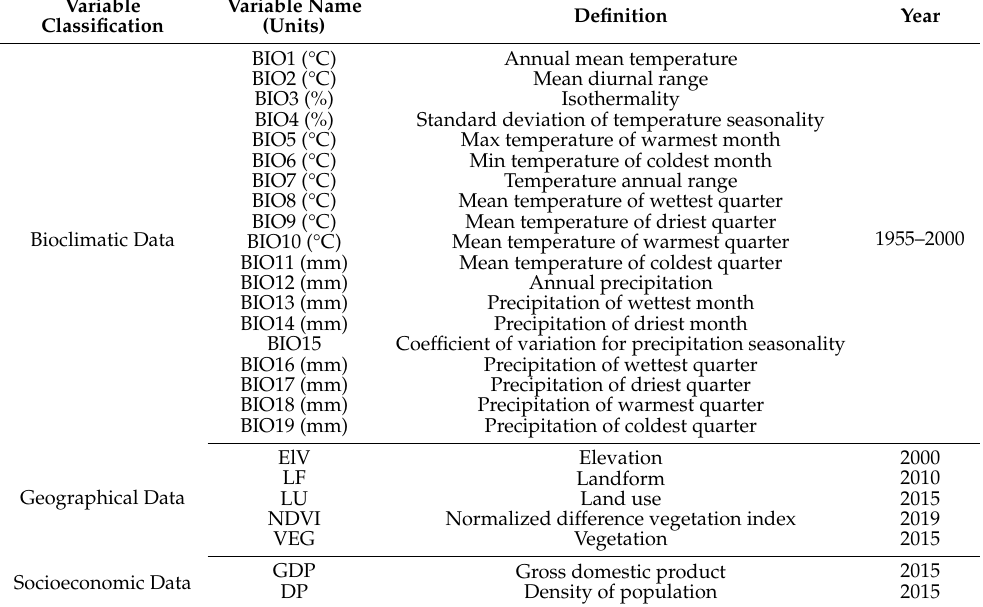
Table 1. Environmental variables affecting the distribution of mountain-type zoonotic visceral leishmaniasis and Ph. chinensis